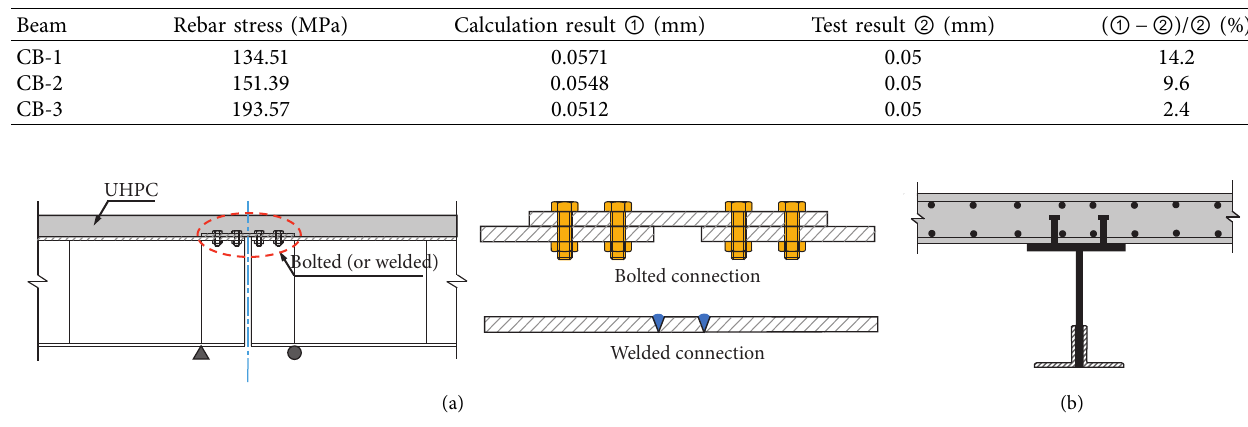
Figure 14: Joint form in the construction site: (a) bolted connection and welded connection and (b) web stiffener for CB-3.